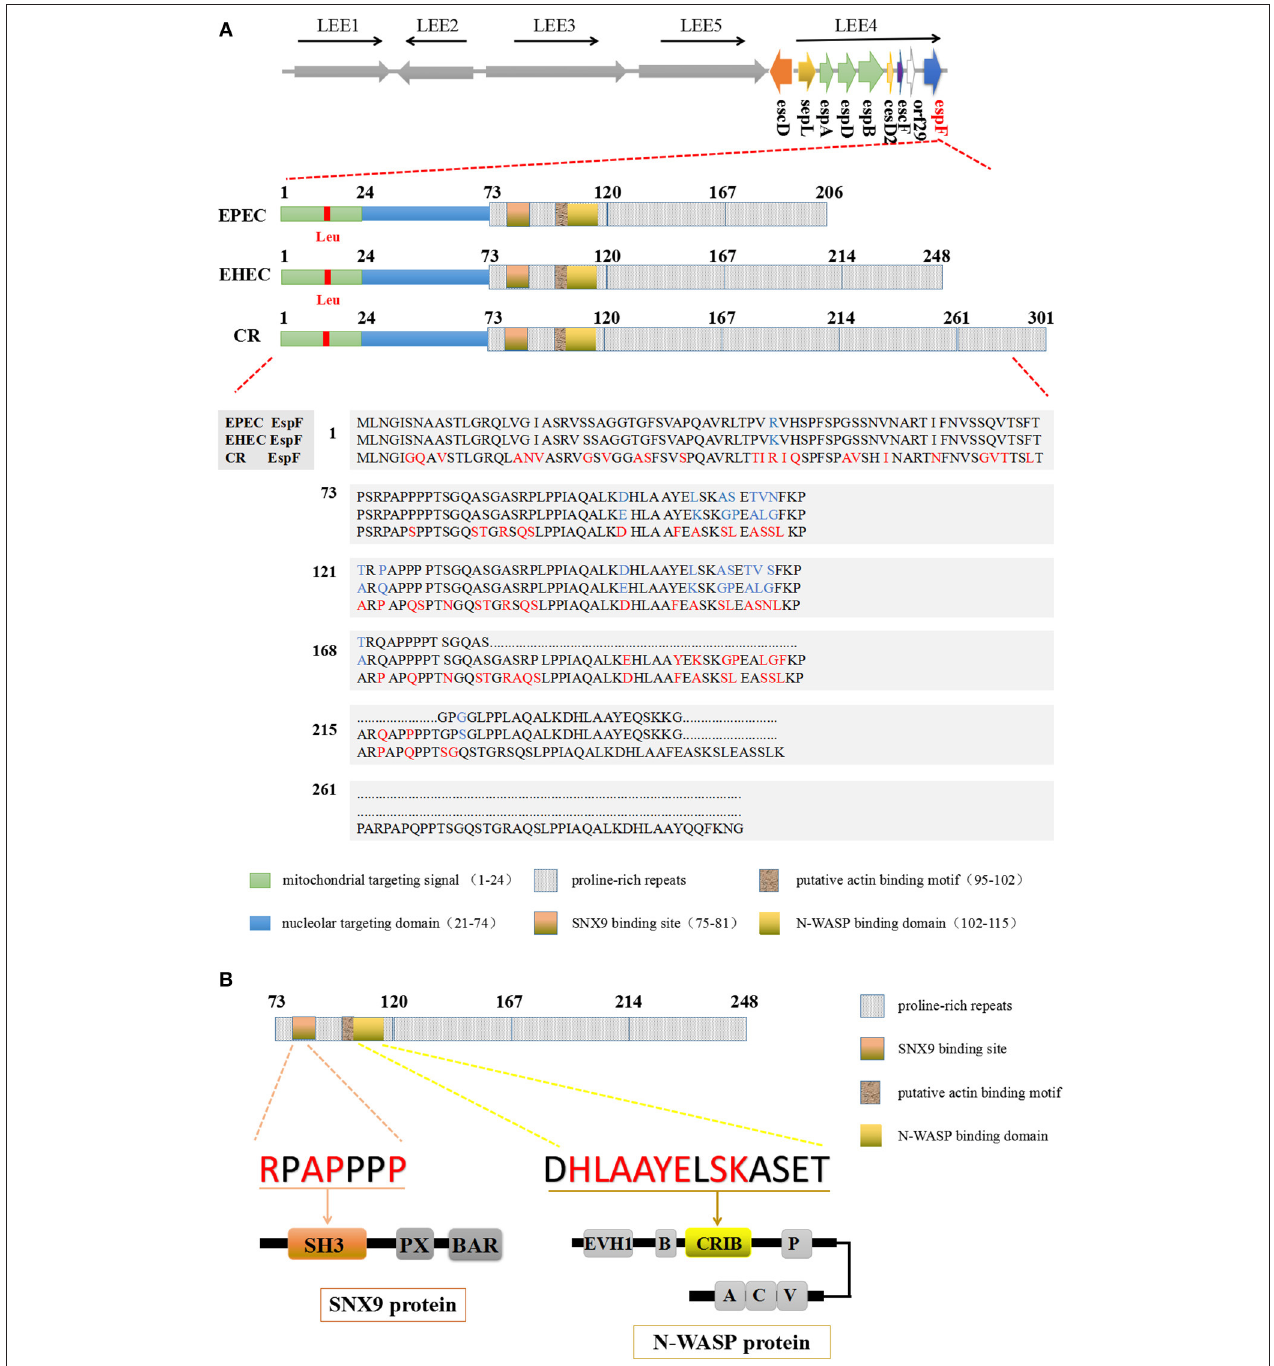
FIGURE 1 | The domain architecture of the EspF protein. (A) EspF amino acid sequences and domain architecture diagrams of EPEC O127:H7 strain E2348/69, EHEC O157:H7 strain EDL933, and C. rodentium are shown. Differences in the size of their EspF proteins are caused by differences in the number of repeats of PRR in the C-terminal domain. (B) EHEC EspF protein C-terminal PRR repeats, including the SNX9 protein binding motif RxAPxxP, and the N-WASP protein binding sequence xHLAAYExSKxxxx.